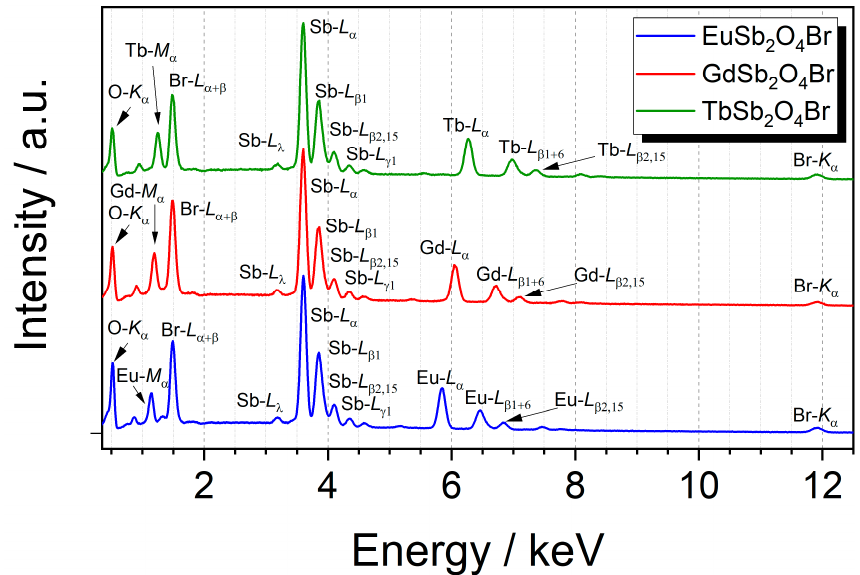
Figure 9. Energy-dispersive X-ray spectra of the Ln Sb 2 O 4 Br series with Ln = Eu–Gd at an acceleration voltage of 20 kV with assignment of the relevant emission lines.